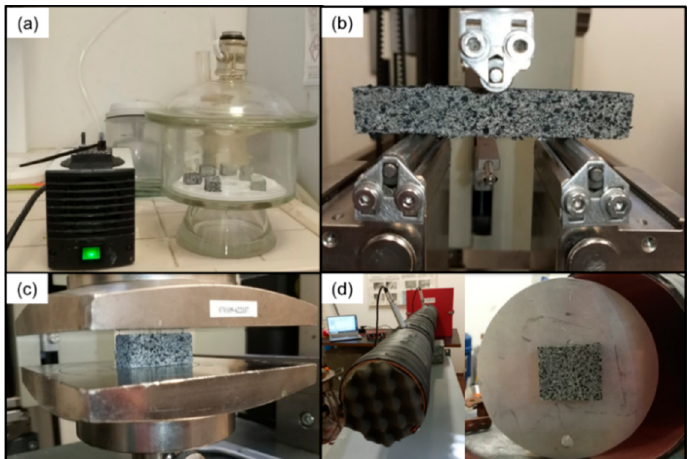
Figure 3. Graphical overview of the experimental program for materials characterization: ( a ) vac- uum saturation method, ( b ) three-point flexural test, ( c ) compressive test, and ( d ) acoustic flow re- sistivity measurement.